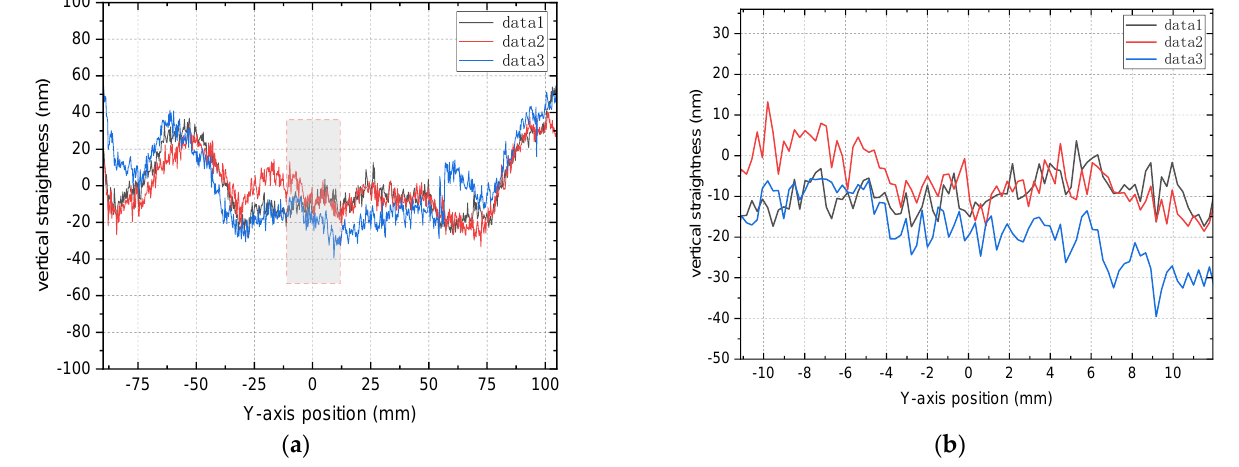
Figure 11. ( a ) Straightness error in the Y -axis vertical direction. ( b ) Straightness error of machining position in Y -axis vertical direction.